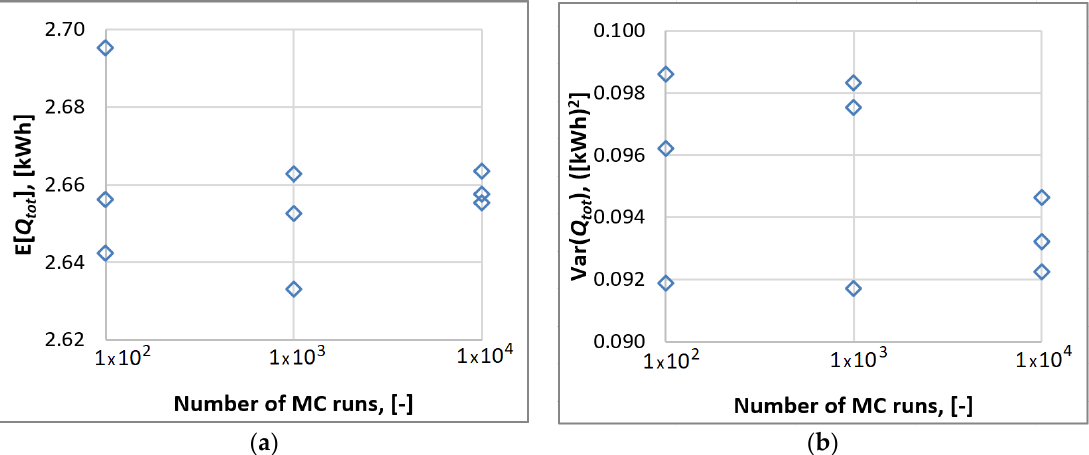
Figure 3. Comparison of ( a ) expected value and ( b ) variance of the total heat loss in January through 1 m 2 of wall obtained using the Monte Carlo method for different numbers of the Monte Carlo runs for Case 1.